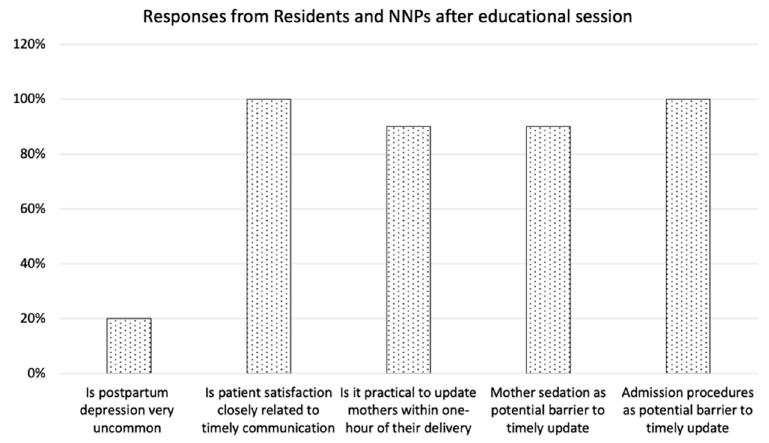
Figure 3. Summary of responses from residents and neonatal nurse practitioners after educational session.